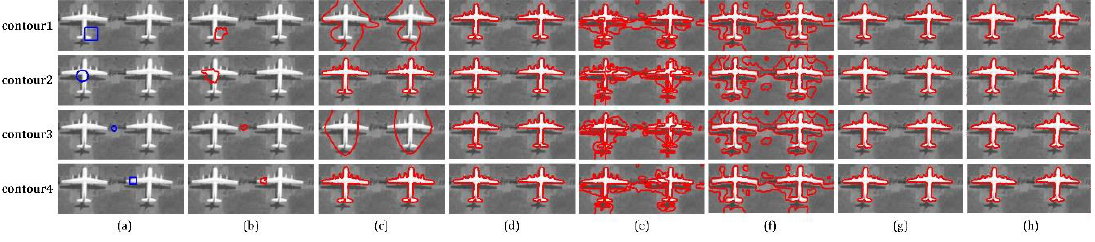
Figure 17. Segmentation results of ‘plane’ image with different initial contours: ( a ) initial contour; ( b ) GAC; ( c ) CV; ( d ) SBGFRLS; ( e ) LBF; ( f ) ILFE; ( g ) Cao’s model; ( h ) the proposed method. Remote Sens. 2018 , 10 , x FOR PEER REVIEW